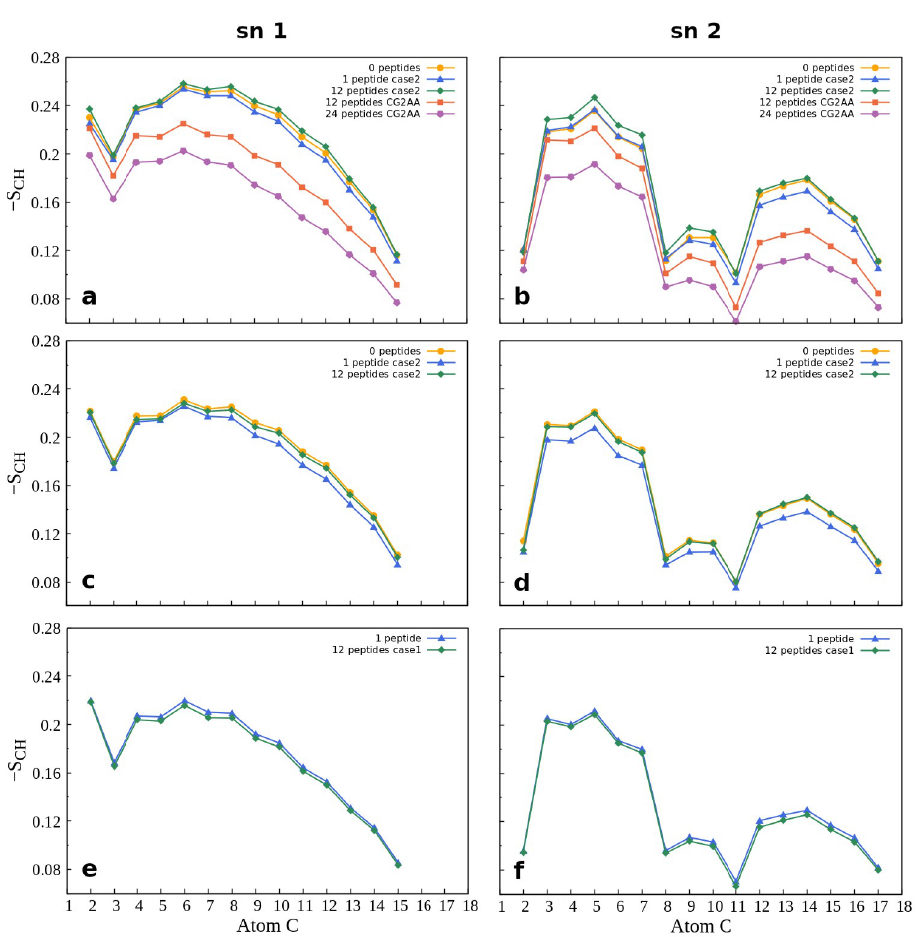
Figure 8. Order parameter − S CH for the acyl chains sn-1 (on the left) and sn-2 (on the right) as a function of the carbon atom index. The first row ( a , b ) shows the results for POPG lipids in POPE:POPG membrane, while the second row ( c , d ) shows the calculations for POPG lipids in POPG:Lys-PG:PVCL2 membrane, and the third row ( e , f ) shows calculations for POPC lipids in POPC membrane. Supplementary Figure S22 shows additional order parameter calculations.